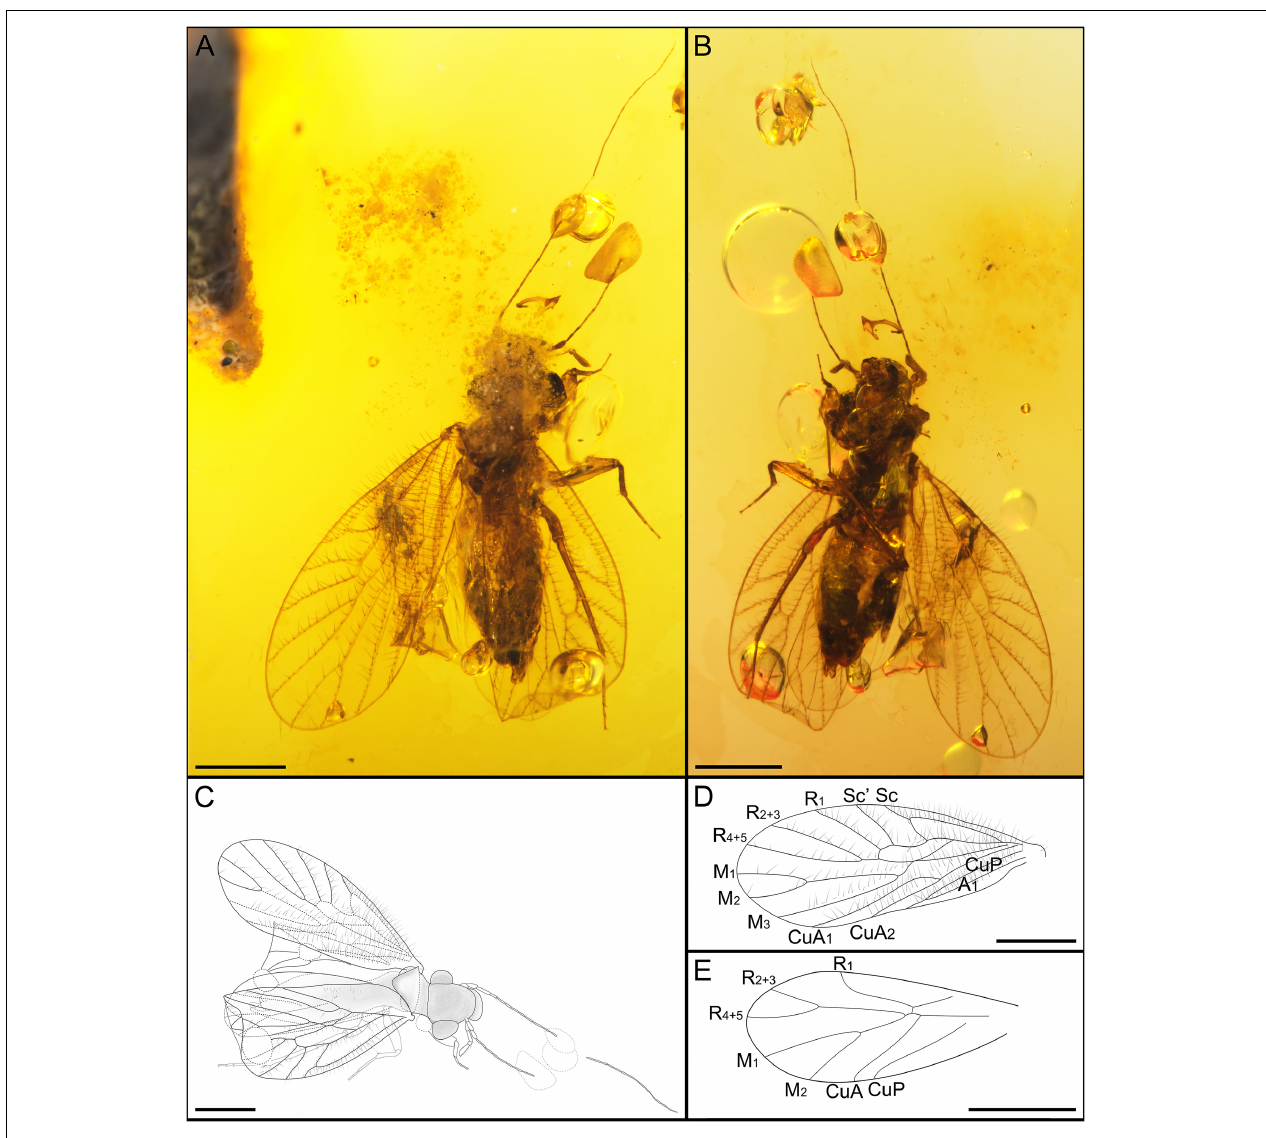
FIGURE 2 | Habitus of Latempheria kachinensis Li, Yoshizawa and Yao, gen. et sp. nov. CNU-PSO-2015001. (A) Photograph in dorsal view; (B) photograph in ventral view; (C) line drawing in dorsal view; (D) line drawing of forewing; (E) line drawing of hind wing. Scale bars:0.5